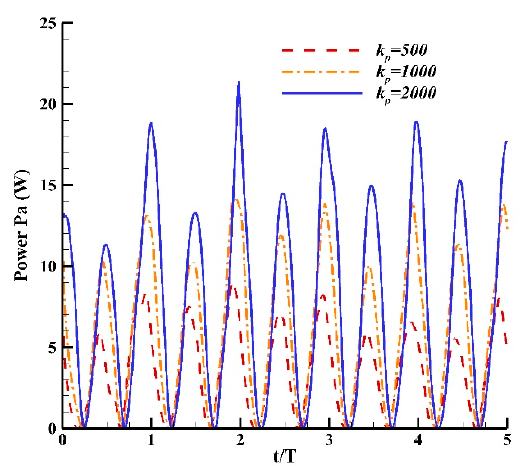
Figure 21. Time histories of instantaneous absorbed power of the buoy ( H = 0.1 m, T = 2.50 s).